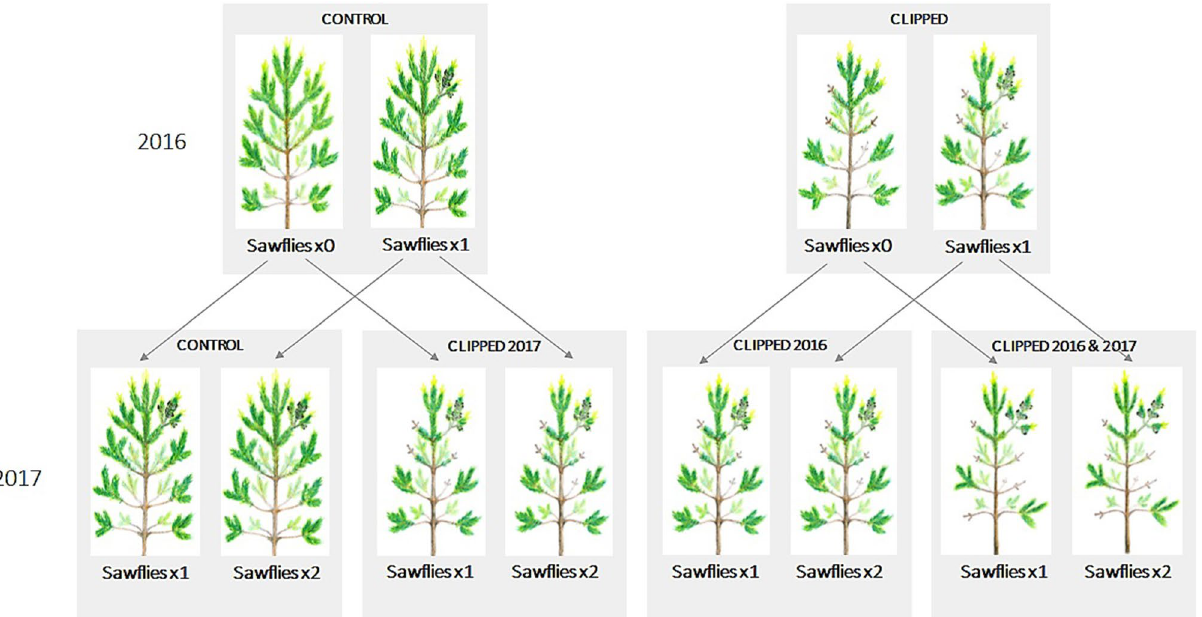
Figure 4. Experimental treatments of pine trees in 2016 and in 2017. Trees were either clipped, exposed to sawflies or both. In 2016 there were four treatments: (i) control (no clipping) and no sawflies, (ii) control (no clipping) and sawflies, (iii) clipped and no sawflies and (iv) clipped and sawflies. In 2017 there were eight treatments: (i) control (no clipping) and sawflies 2017, (ii) control (no clipping) and sawflies 2016 and